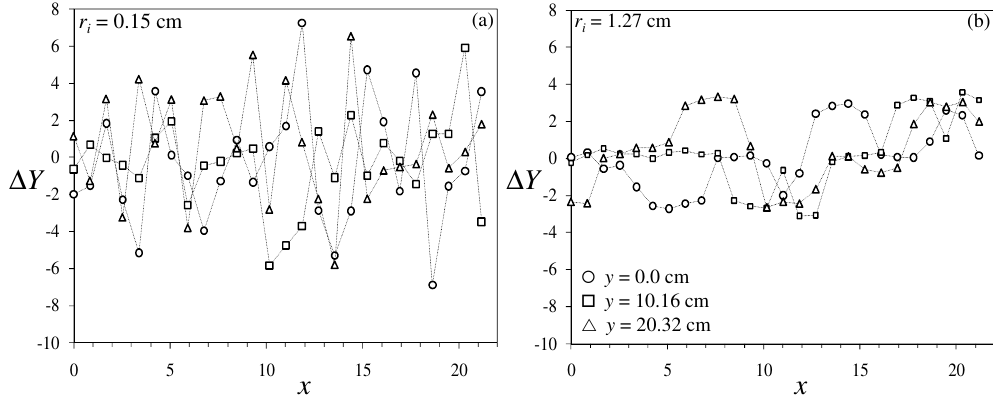
Fig. 2. Increments, 1Y ( s x =8.5cm), versus position, x , along three transects on face 1 ( y =0, 10.16, 20.32cm) for (a) r i =0.15cm and (b) r i =1.27cm.